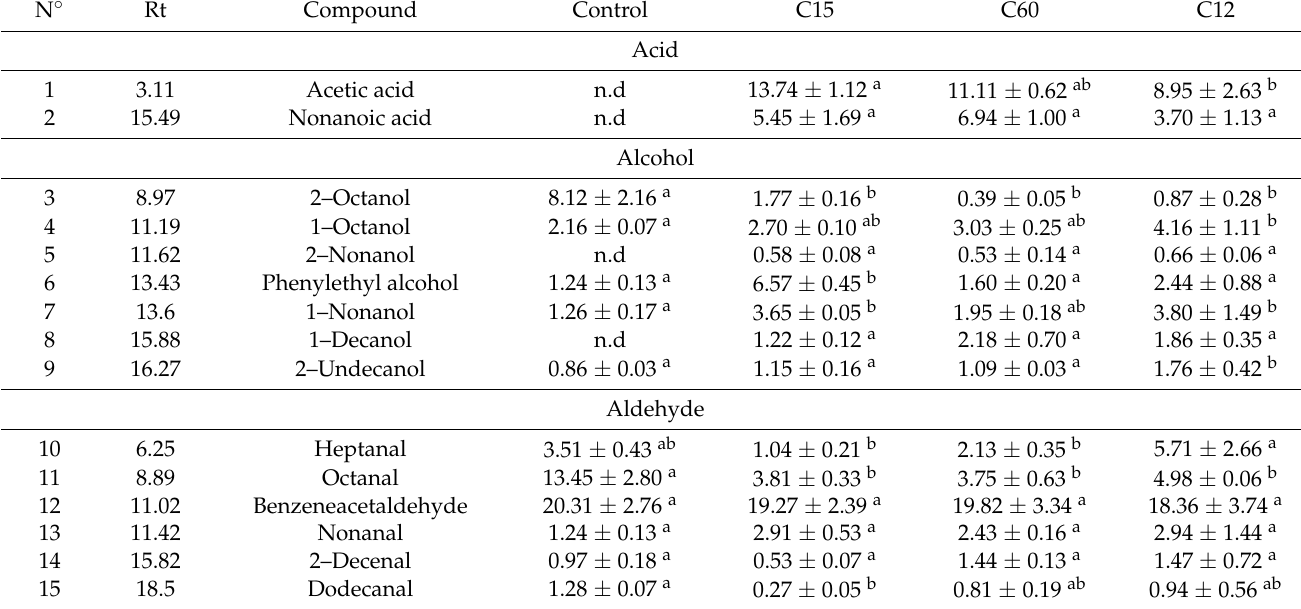
Table 6. Percentage area (%) of the volatile organic compounds (VOCs) identified in the